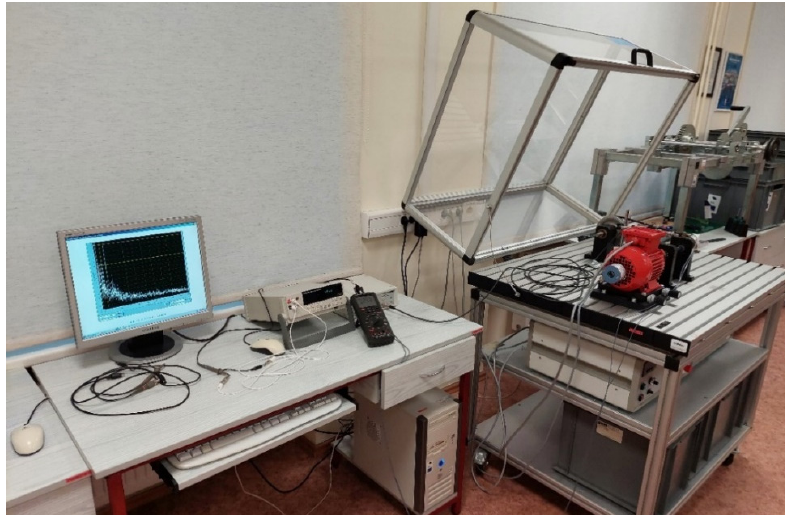
Figure 7. Experimental test bench.